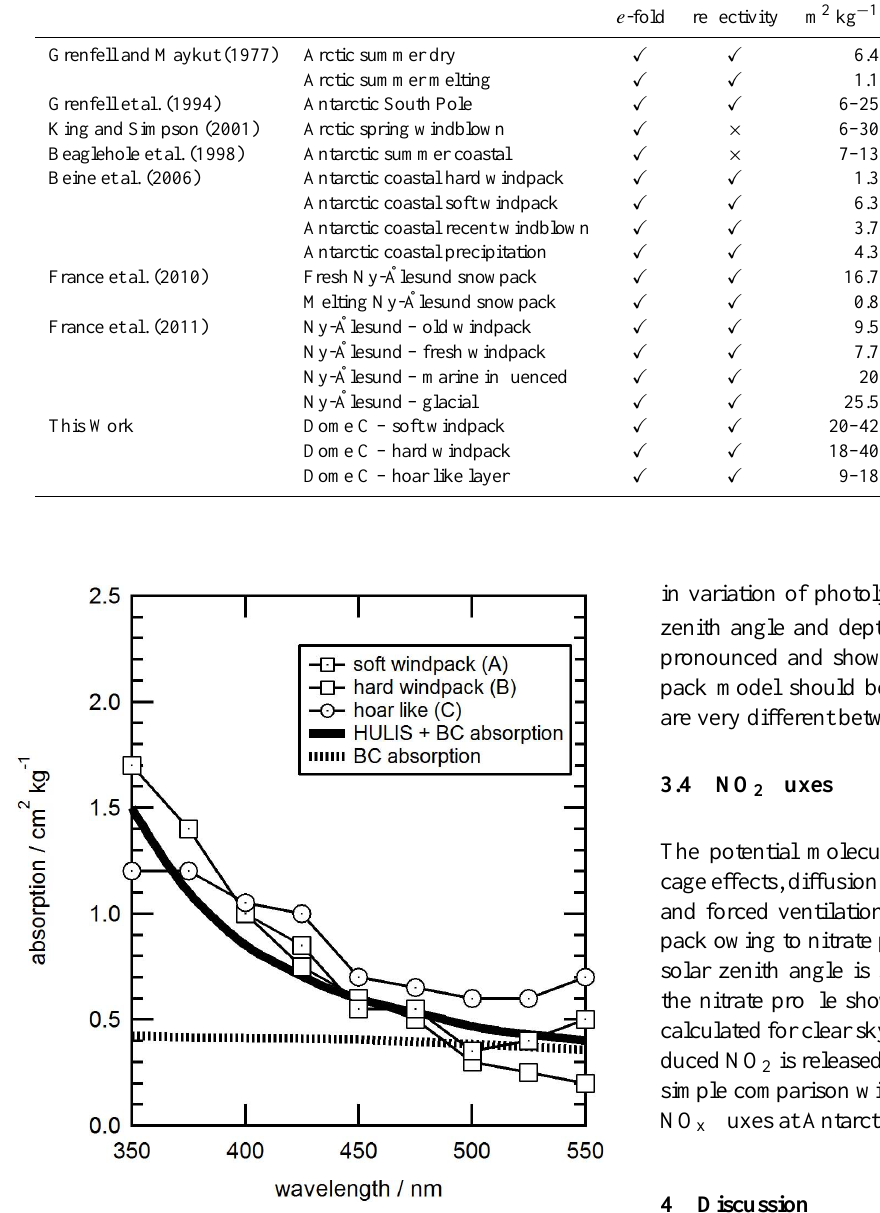
Fig. 3. Absorption, σ + , versus wavelength for impurities in the abs snowpack layers. The absorption due to impurities can be fitted to a linear combination of absorption cross-sections due to HULIS (Hoffer et al., 2006) and black carbon (see text). The linear combi- nation of absorption cross-sections for HULIS and black carbon in the figure is illustrative and not fitted to a specific snowpack